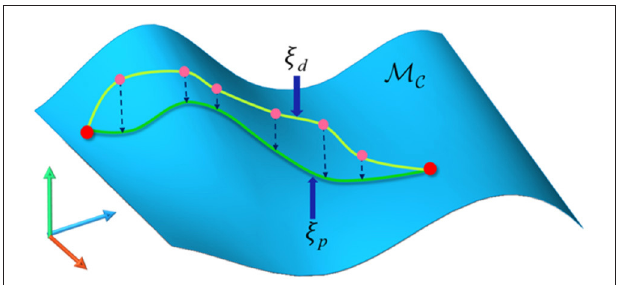
FIGURE 5 | The candidate trajectory is projected onto the constraint manifold. M C is the constraint manifold. ξ d is the candidate trajectory produced by LCQP iteration which may slightly violate task constraints. After projection operations, ξ p returns to the manifold surface, which means the constraints are strictly satisfied again.